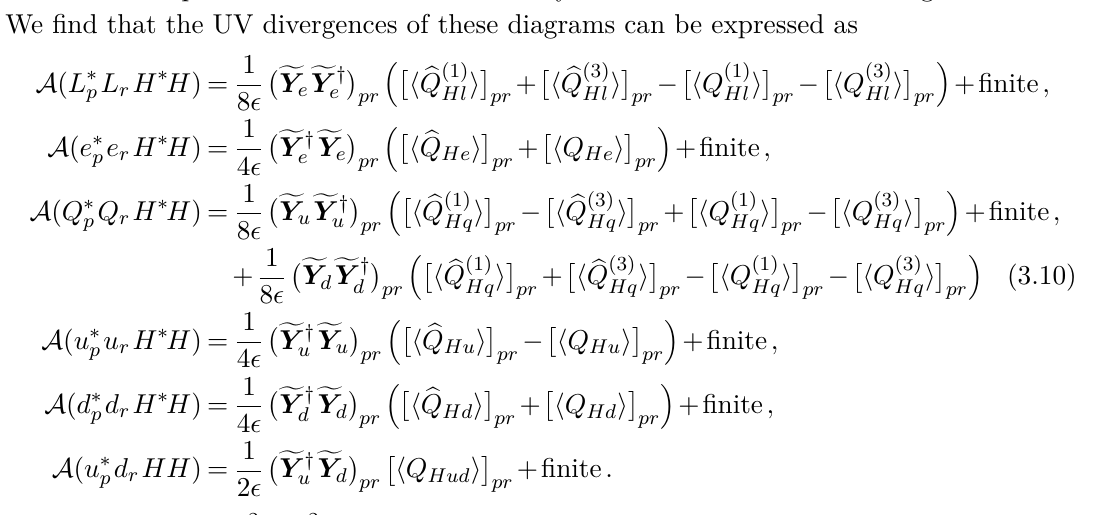
Figure 5 . Representative one-loop Feynman diagrams with ALP exchange (red dashed line), which require operators in the class ψ 2 H 2 D as counterterms. Analogous graphs exist in the lepton sector. which are not part of the Warsaw basis. They will later be eliminated using the